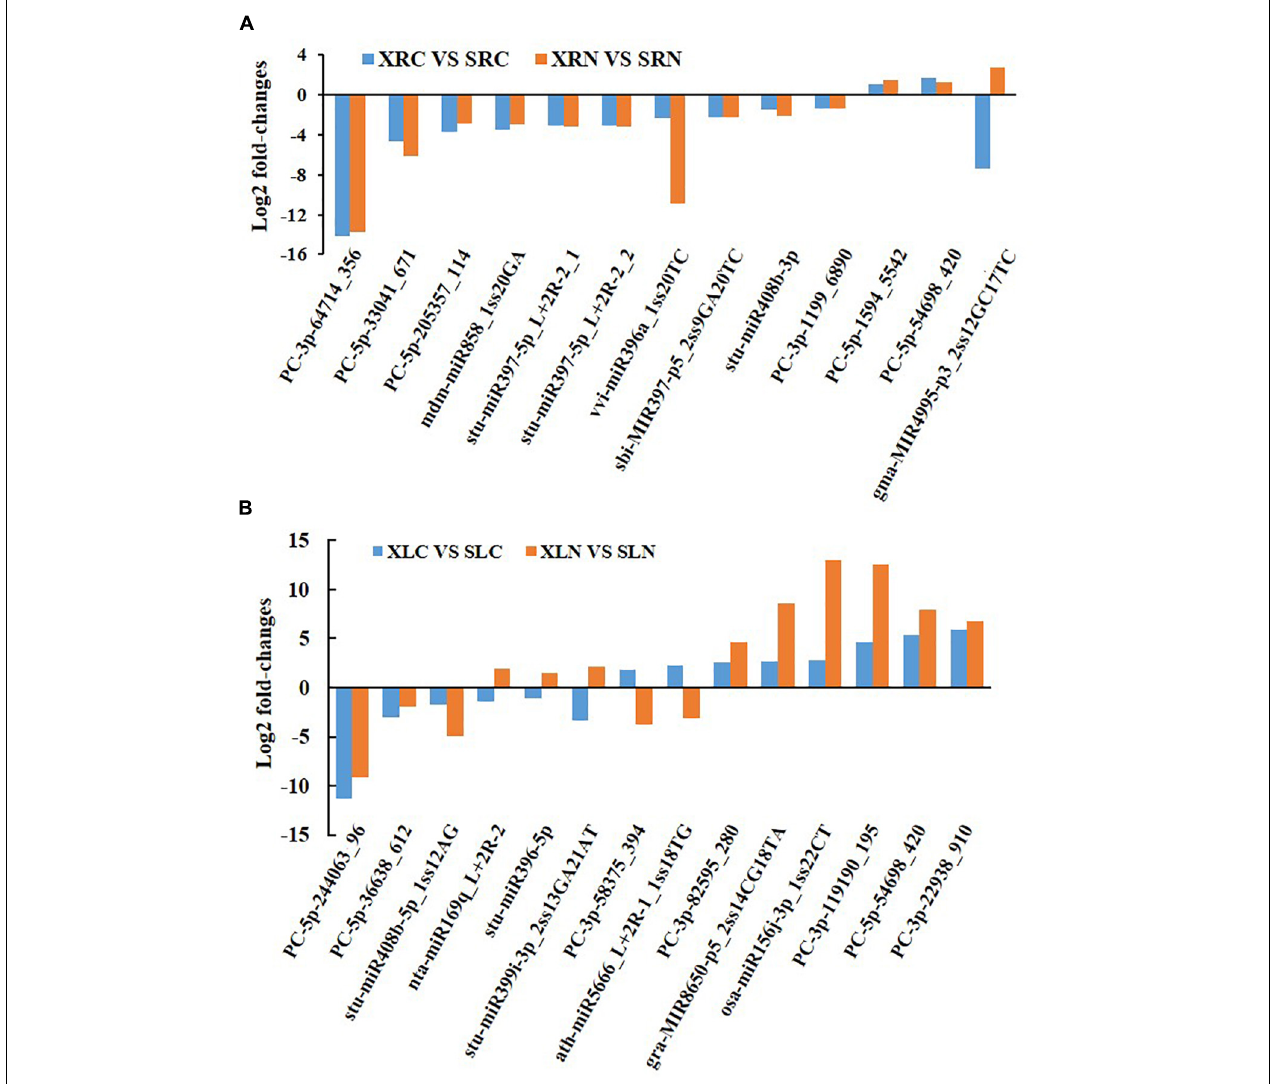
FIGURE 4 | Comparative analysis of miRNA expression between two different genotypes under NaCl treatment or untreated condition. (A) Differently expressed miRNAs in roots. (B) Differently expressed miRNAs in leaves.